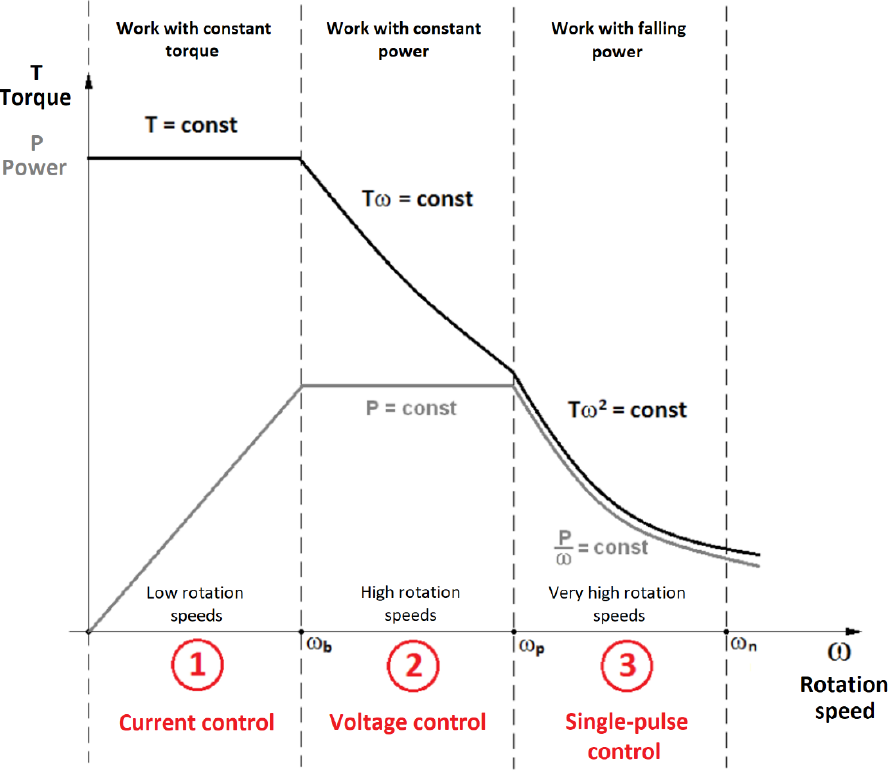
Figure 6. Simplified mechanical characteristics of the SRM motor with marked properties: scope of work and control system.